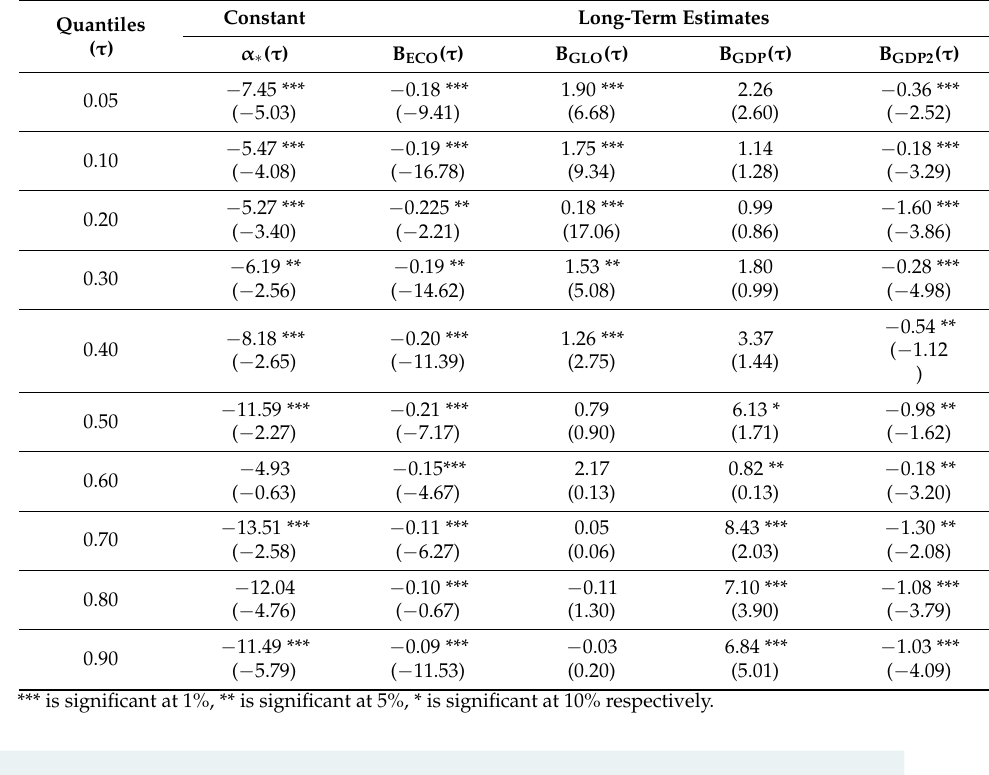
Table 5. The impacts of ECO, GLO, and GDP on CO 2 .